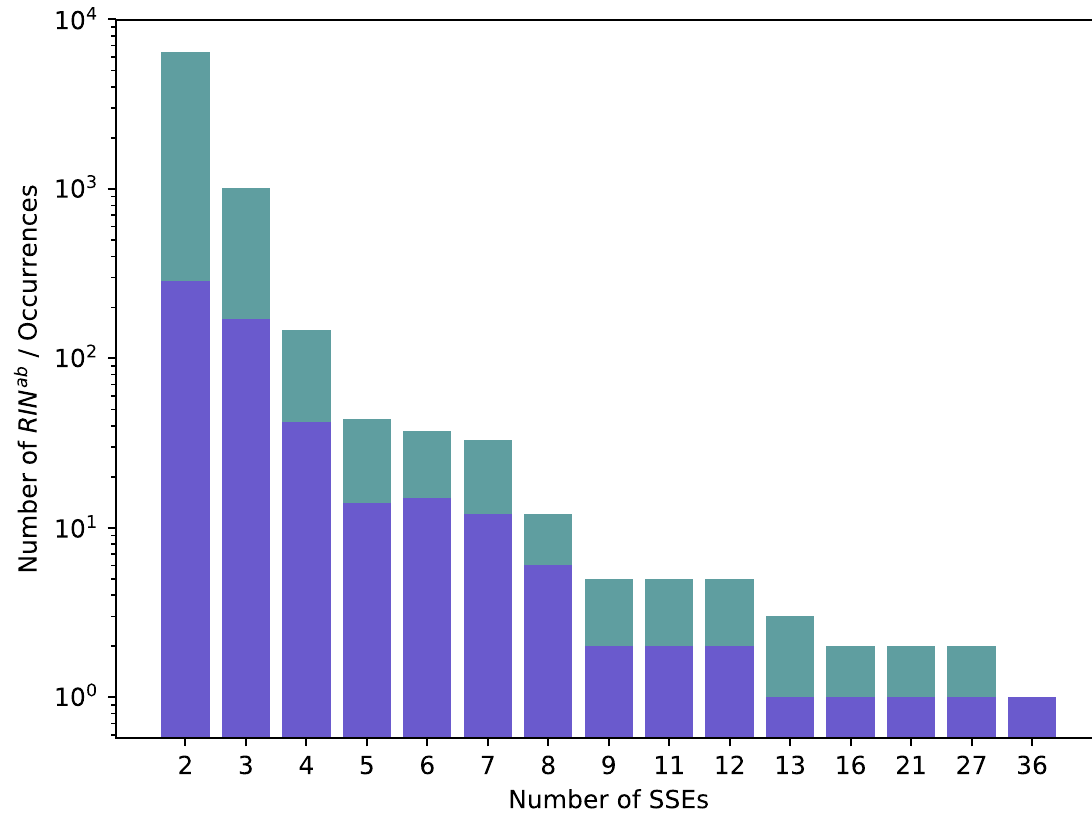
Fig 8. Distribution of RIN ab in Dataset 2.92. Numbers of distinct RIN ab s numbers of SSEs they span over in Dataset 2.92.